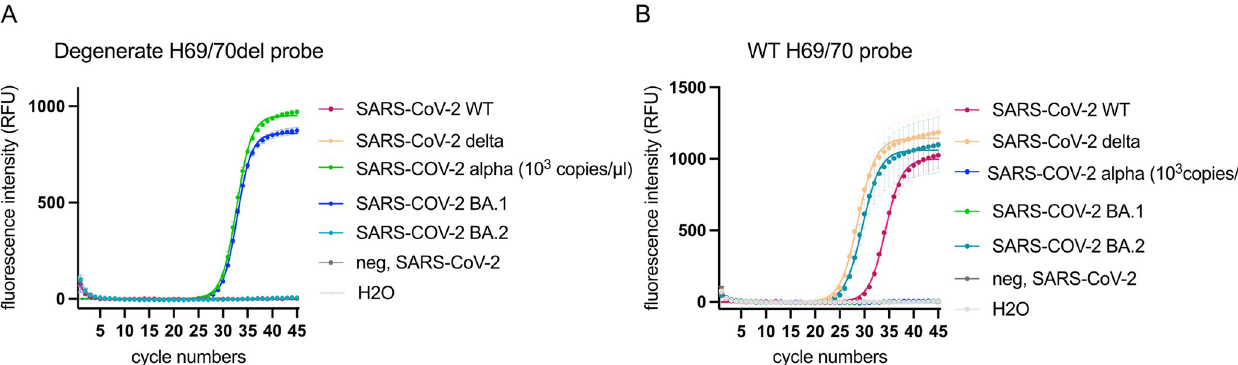
Fig 2. Detection of SARS-CoV-2 variants with a degenerate Δ H69/V70 probe based on the SARS-CoV-2 BA.1 sequence. (A) Detection of SARS-CoV-2 variants with a degenerate probe targeting the Δ H69/V70. The SARS-CoV-2 Alpha- and BA.1 variants were included as positive controls, and SARS-CoV-2 negative patient samples and a water as negative controls. (B) Detection of SARS-CoV-2 variants with the WT probe. SARS-CoV-2 WT, Delta and BA.2 variants were included as positive controls and SARS-CoV-2 negative patient samples and a water as negative controls.